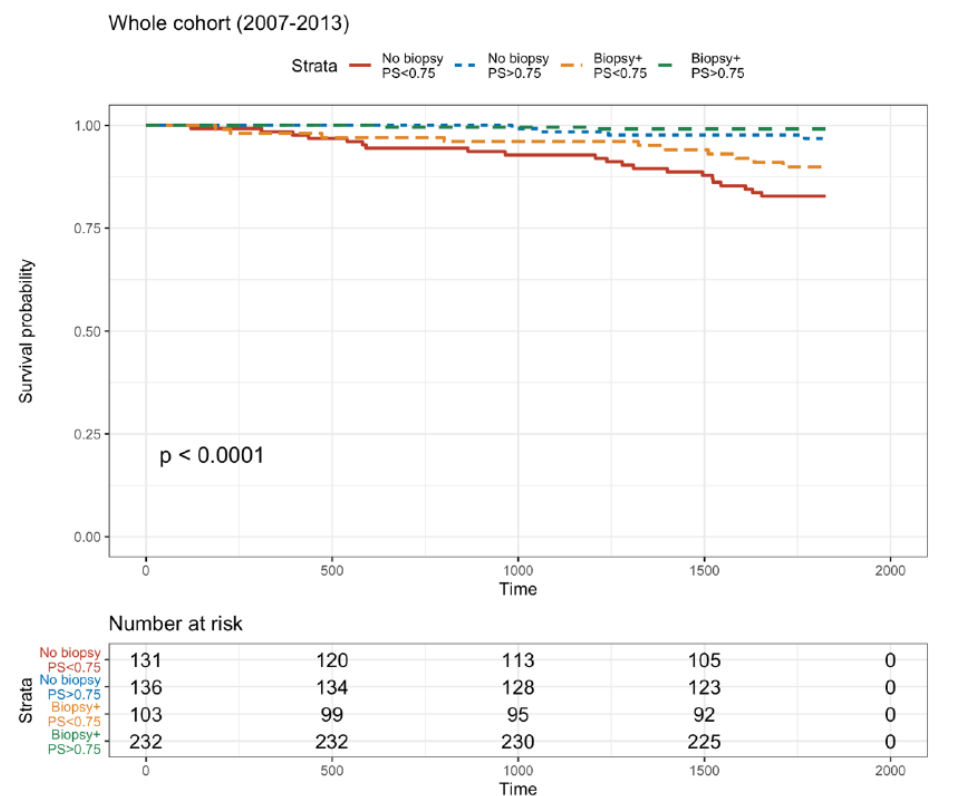
Figure 3. Five-year death–ensored graft survival (DCGS) for the whole cohort, with respect to systematic kidney biopsy at M3 and to the propensity score.